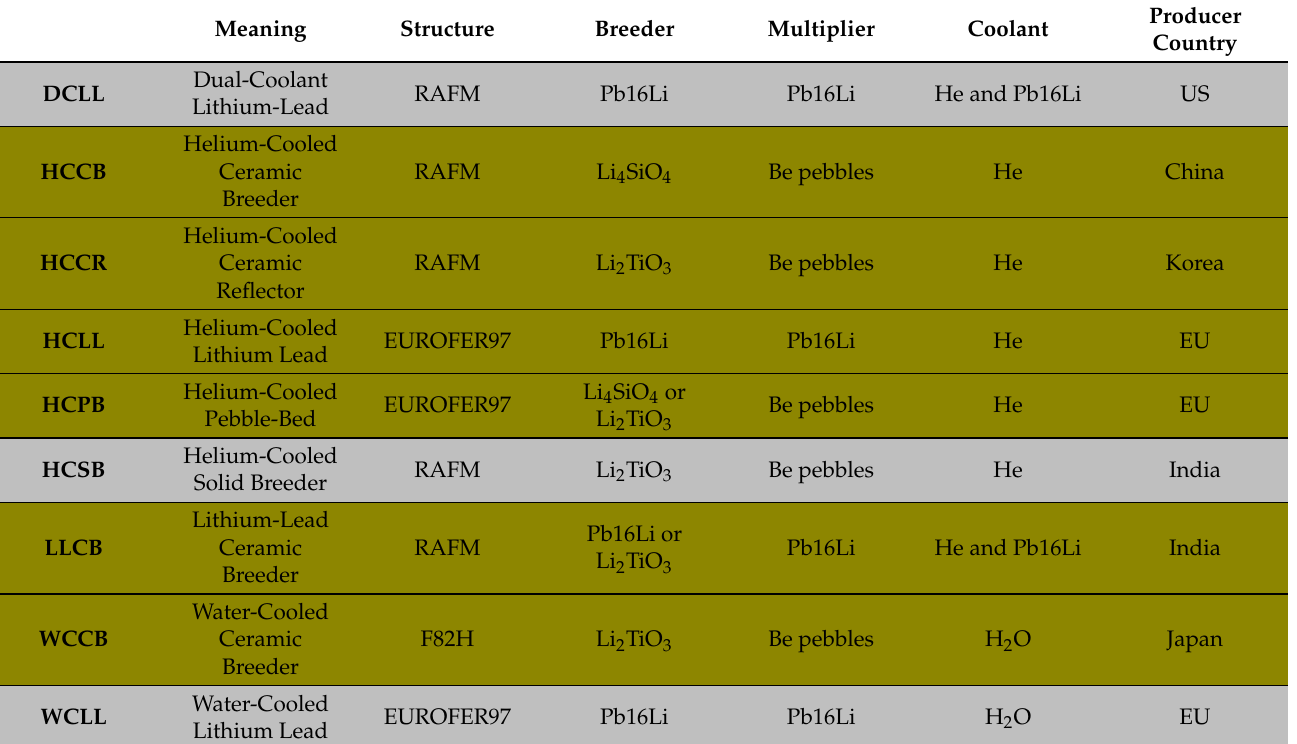
Table 3. Composition of the nine main TBM designs. Six of them are more developed , and the remaining three have been recently approved